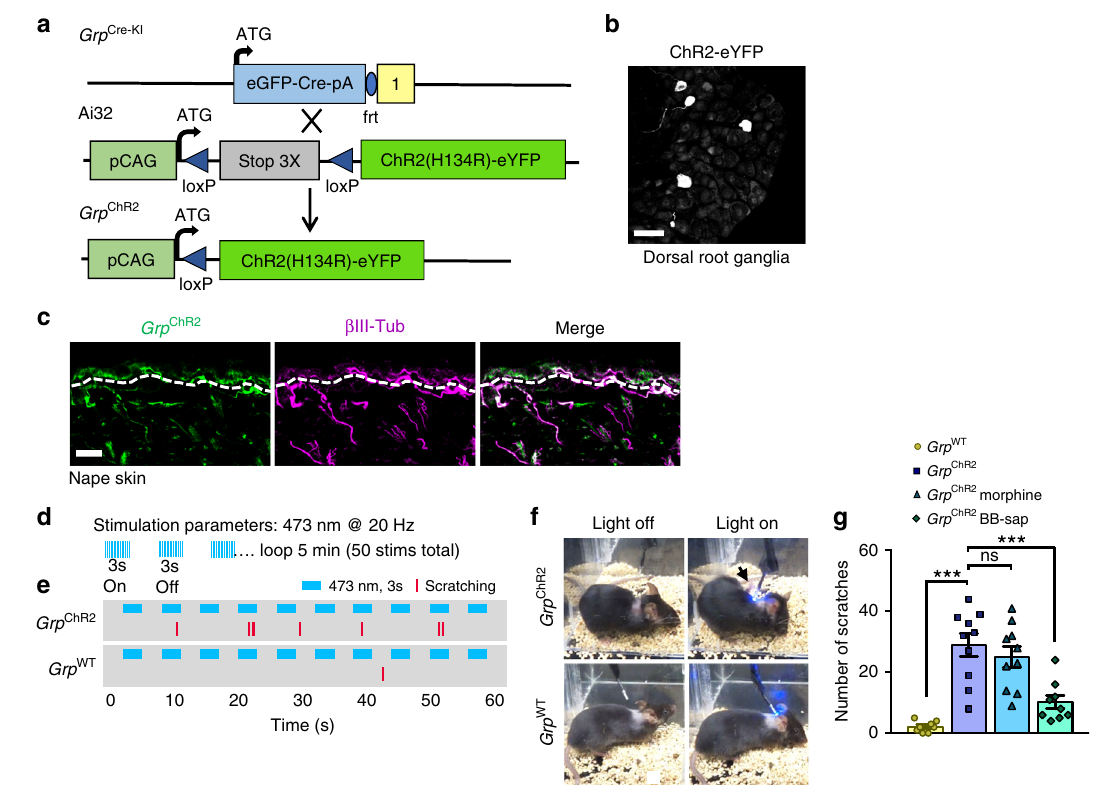
Fig. 5 Opto-activation of Grp + sensory neuron skin fi bers evokes itch behavior. a Schematic of Grp Cre-KI mating with Ai32 ChR2-eYFP line to produce Grp ChR2 mice. b IHC Image of eYFP expression in Grp ChR2 DRG. Scale bar, 50 μ m. c IHC images of eYFP and β III-Tubulin in Grp ChR2 nape skin. Dashed lines indicate epidermal/dermal boundary. Scale bar, 100 μ m. d Optical parameters of skin fi ber stimulation Grp ChR2 and Grp WT mice. e Raster plot of scratching behavior induced by light stimulation of skin in Grp ChR2 and Grp WT mice. f Snapshots of Grp ChR2 and Grp WT mice with light off or on. Arrow indicates hind paw scratching the nape when light is on. g Total number of scratches during 5-min light stimulation experiment in Grp WT , Grp ChR2 , Grp ChR2 morphine- treated and Grp ChR2 BB-sap-treated mice. Data are presented as mean ± s.e.m., n = 8 mice for Grp WT , 9 mice for Grp ChR2 BB-sap, and 10 mice for Grp ChR2 and Grp ChR2 morphine, one-way ANOVA with Tukey post hoc, *** p < 0.001, ns not signi fi cant. Source data are provided as a Source Data fi